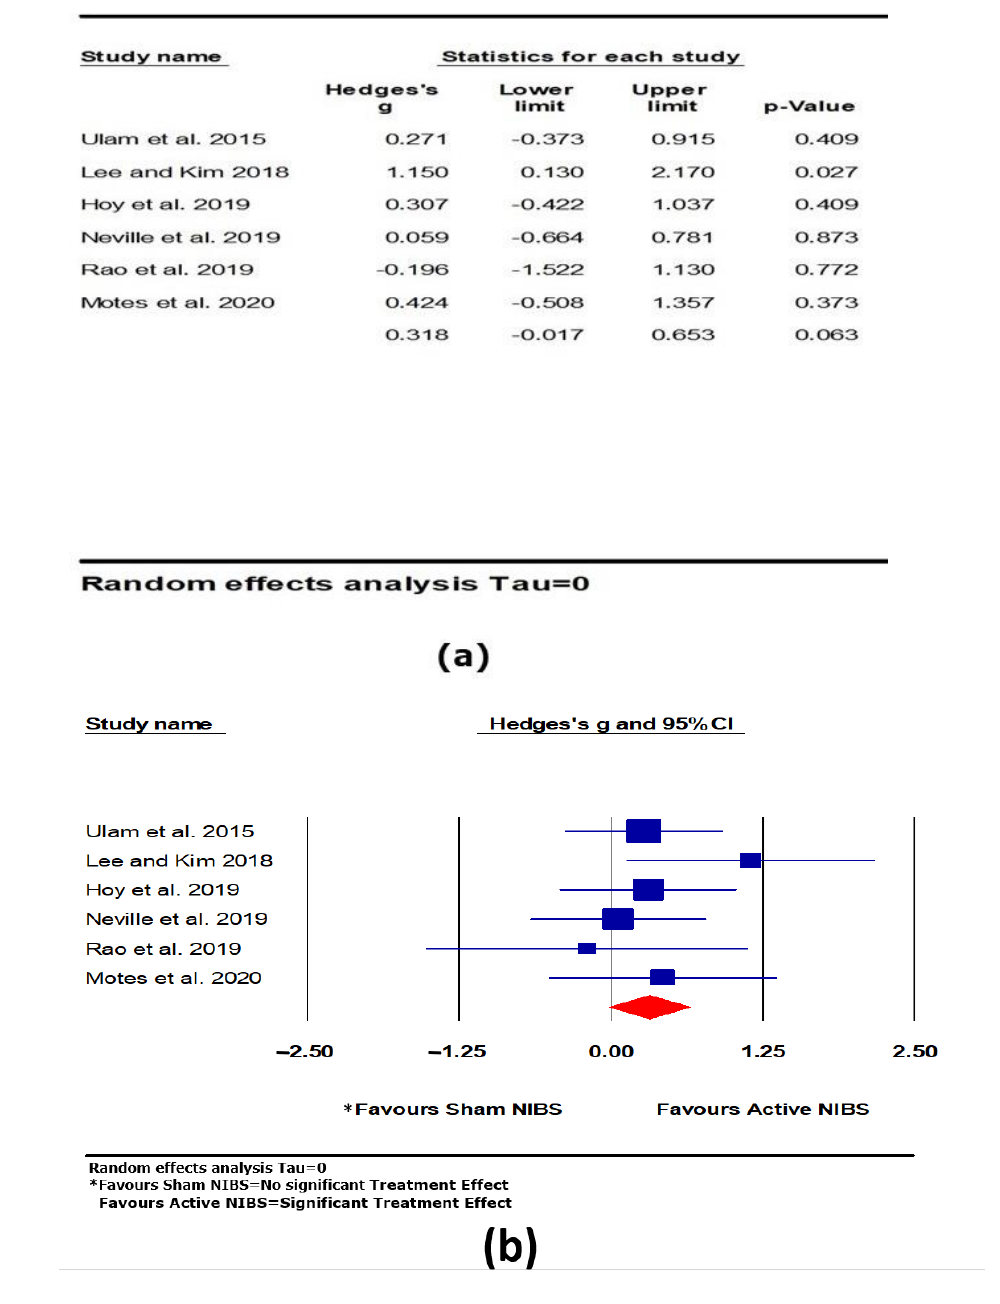
Figure 6. The effect of non-invasive brain stimulation (NIBS) on executive function; ( a )